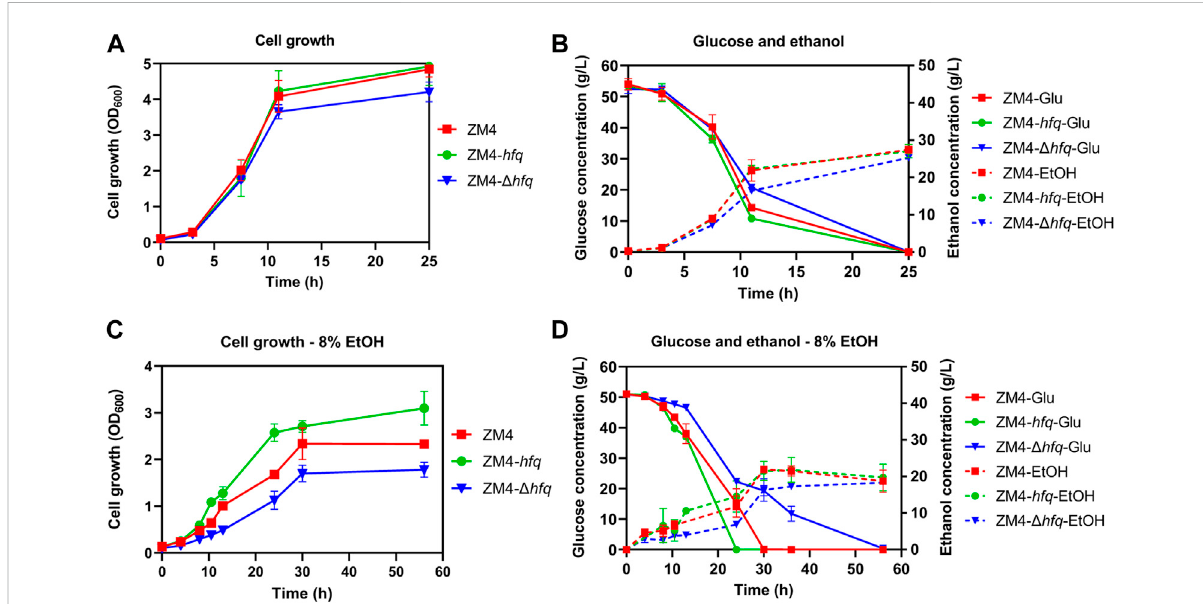
FIGURE 1 Thecell growth, glucose consumptionandethanolproductionof Z.mobilis strains intheabsence ( A,B )orpresence of8%(v/v)ethanol( C,D ). Z. mobilis wild-type (ZM4), hfq overexpression(ZM4- hfq ). hfq deletion(ZM4- Δ hfq )strainswereculturedinRMmediumat30 ° C.Theerrorbarsindicate standard deviations based on three replicates. Glu: glucose, EtOH: ethanol produced from glucose with the exogenous ethanol supplemented into the medium subtracted from the total ethanol amount in the